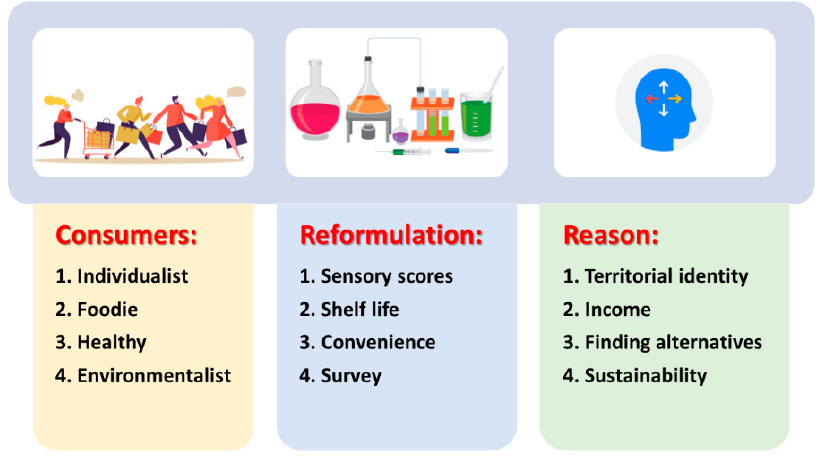
Figure 2. The design of new foods from discards or loss in fishery should rely on three main variables: the target (consumers), the technological aim (reformulation), and the reasons beyond the entire process; this scheme can be regarded as the “virtuous cycle” for new product design from low-value or discards of fishery.